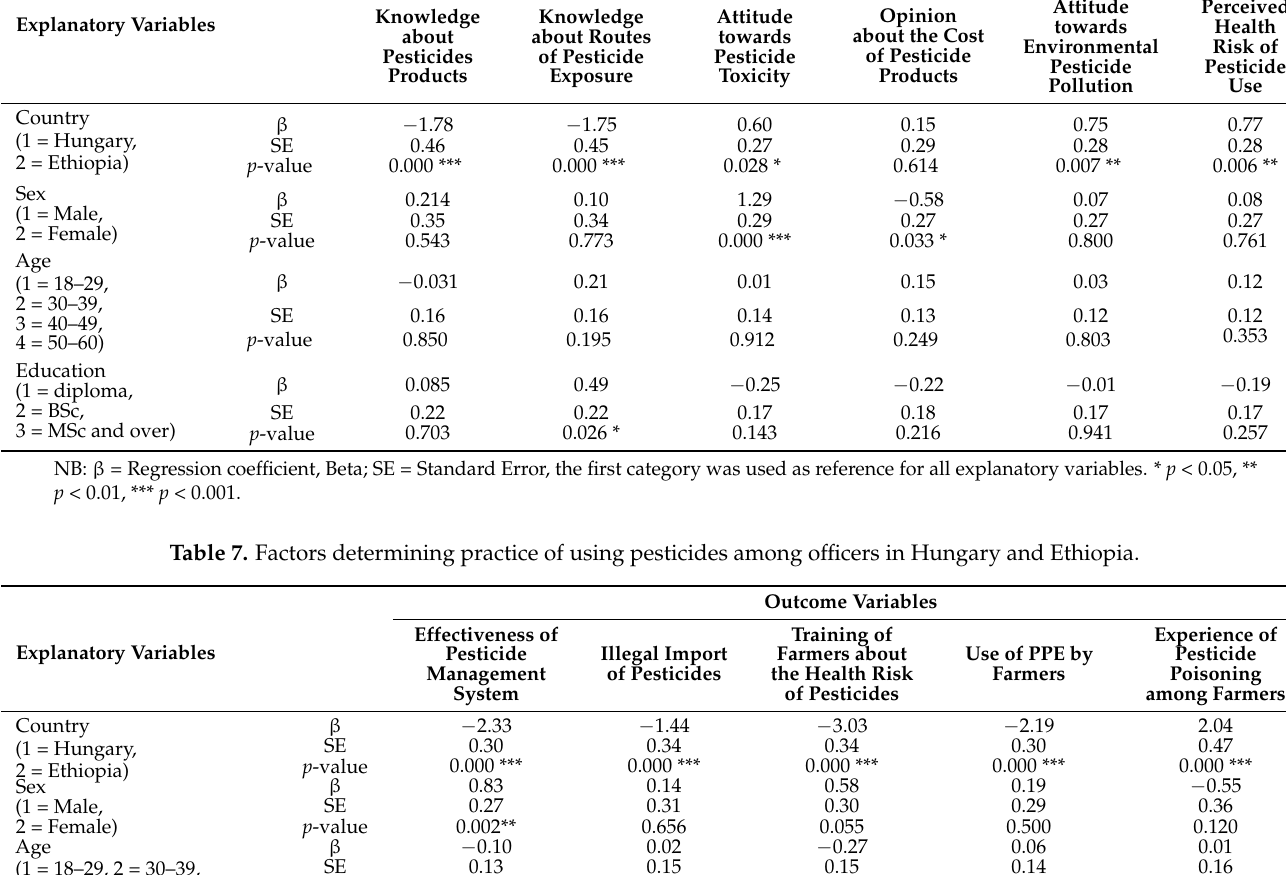
Explanatory Variables